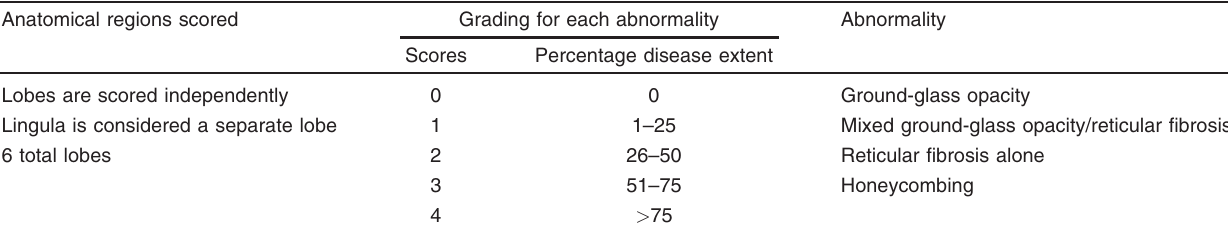
Table 1 Semiquantitative scoring of high-resolution computed tomography [6] Anatomical regions